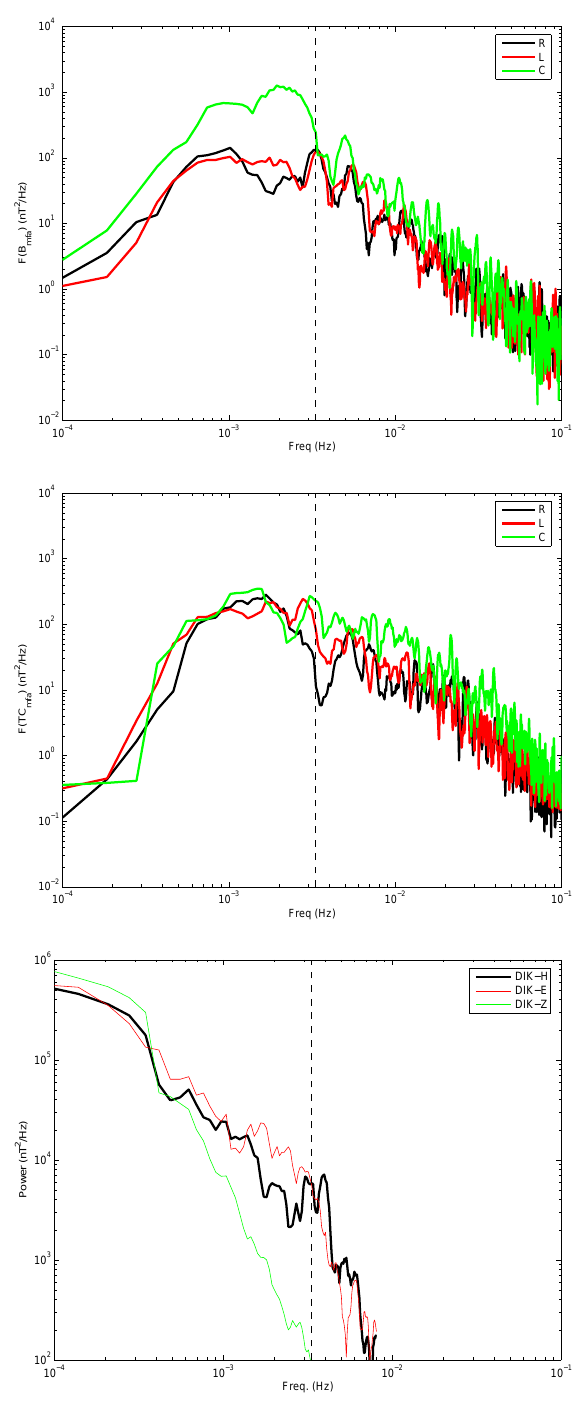
Fig. 5. Power spectra for Cluster, TC-1 and DIK for the interval 19:00–21:00 UT. For C1 and TC-1 the spectra are shown in a MFA coordinate system with compressional, left- and right-handed polar- ized waves. The DIK spectra are from the H, E and Z components of the ground magnetic field. Note that the y -axis for DIK is dif- ferent from the other two. The vertical dashed line indicates the location for 5-min waves at f ≈ 3 .